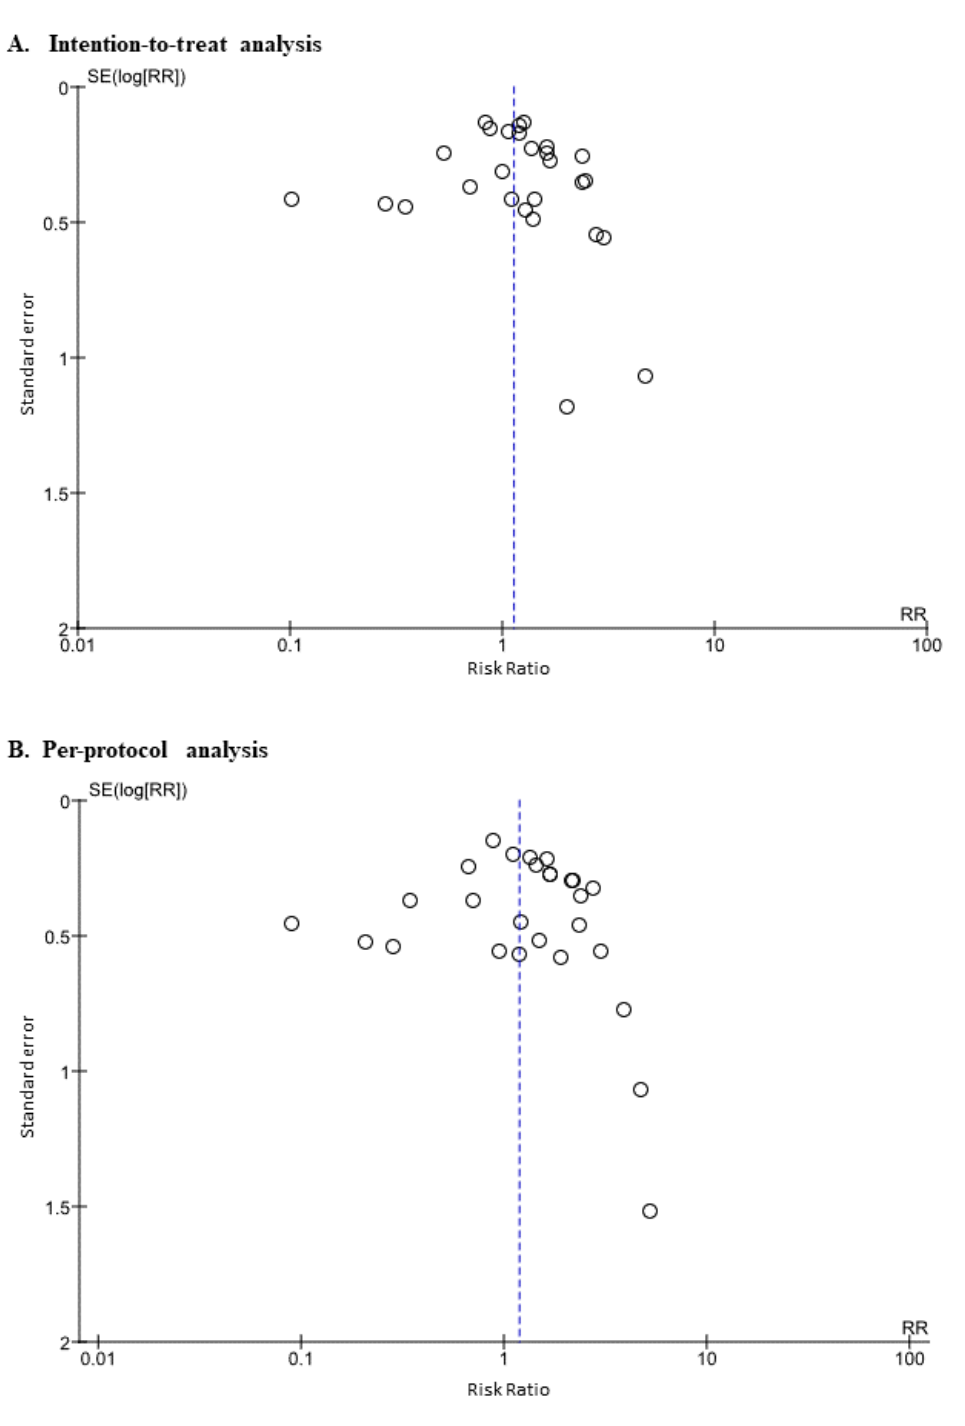
Figure 3. Funnel plot for the comparison of efficacy between PAC therapy and PAM therapy on intention-to-treat analysis ( A ) and per-protocol analysis ( B ). Abbreviation: PAC, proton pump inhibitor (PPI)/amoxicillin/clarithromycin; PAM, PPI/amoxicillin/metronidazole; RR, risk ratio; SE, standard error.